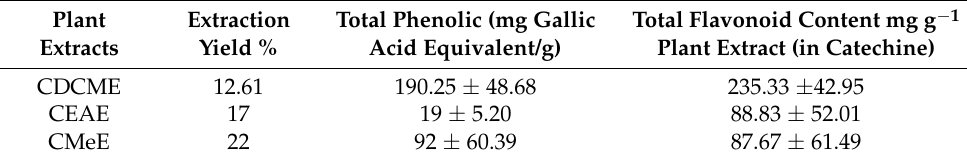
Table 1. Total phenolic, flavonoid content and extraction yield (%) of the different extracts of Oldenlandia corymbosa L.